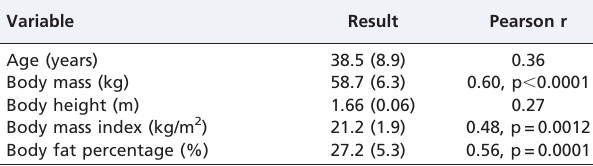
Table 3 - Association of training and pre race experience variables with race time (n= 42).